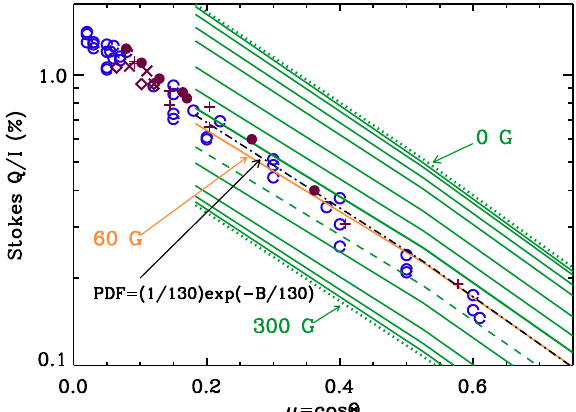
Fig. 34 Sr i 460.7 nm linear polarization measurements at different heliocentric angles θ (symbols) and theoretical modeling (curves). The fractional polarizations that would be produced by isotropic turbulent fields of different strengths are indicated by the green curves, as resulting from NLTE radiative transfer calculations in realistic 3D hydrodynamical models of the solar photosphere (from top to bottom: 0, 5, 10, 15, 20, 30, 40, 50, 60 80, 100, 150, 200, 250, and 300 G). The orange curve corresponds to the best- fitting field strength of 60 G. The black curve shows the variation of the linear polarization assuming an exponential distribution of fields with average strength of 130 G. Image reproduced with permission from Trujillo Bueno et al. (2004), copyright by